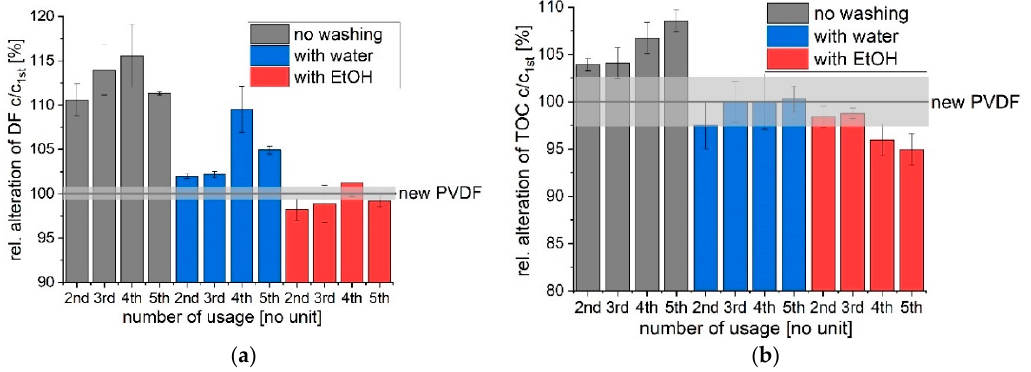
Figure 7. PVDF was reused up to five times (each 0.5 h UVA light irradiation) and either washed with water or ethanol in between or used untreated. Transformation with fresh and unused PVDF was set to 100% and is indicated as new PVDF. The relative alteration of transformation of diclofenac (DF) in ( a ) and TOC in ( b ) in relation to unused PVDF is shown.